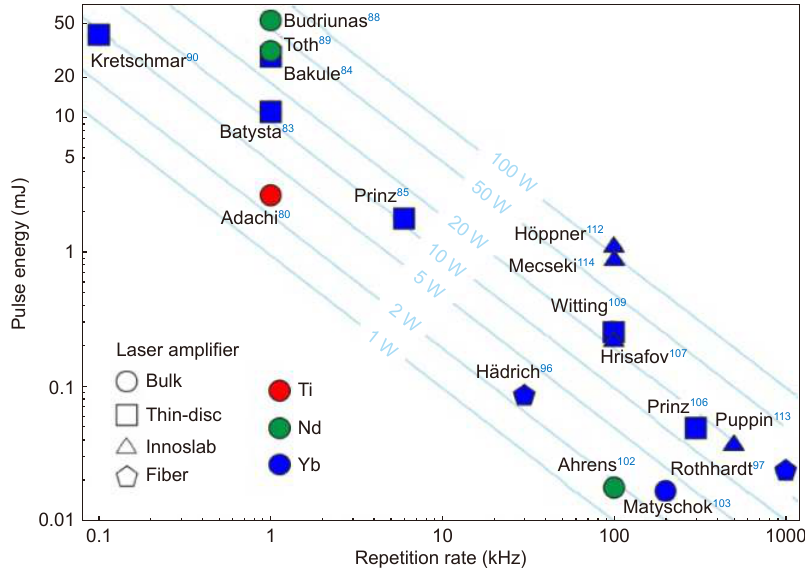
Fig. 5 | Graphical summary of the performance of high average power NIR OPCPA systems. Color coding of data points denotes the gain medium of pump laser, while different shapes indicate the configuration of laser